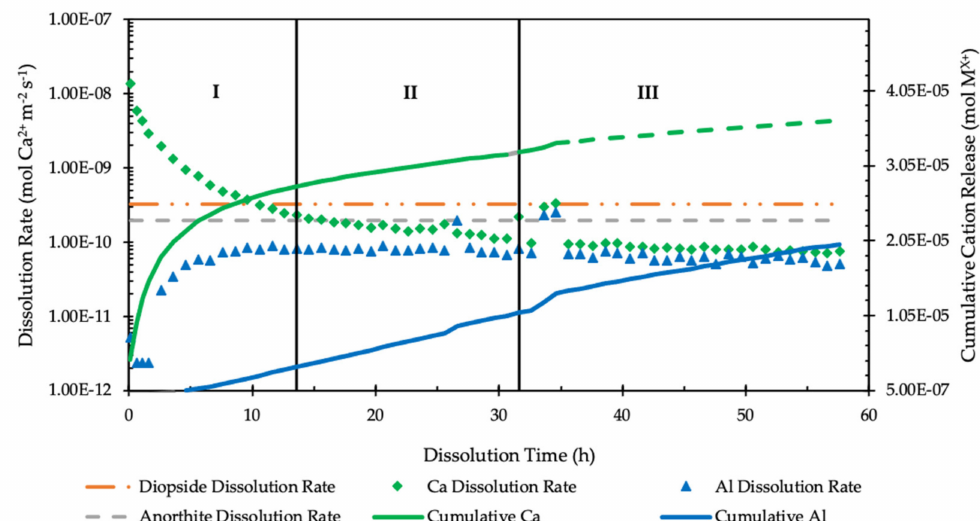
Figure 4. Evolution of Ca 2+ and Al 3+ dissolution rate in Tail 2a (left axis) paired with Ca 2+ and Al 3+ accumulation in solution (right axis). Published dissolution rates of diopside and anorthite are displayed for comparison [41]. The solid accumulation curve indicates values above the ICP detection limit, whereas the dashed curve indicates values below the ICP detection limit. Vertical lines separate distinct regions in the 60-h dissolution process, discussed in the